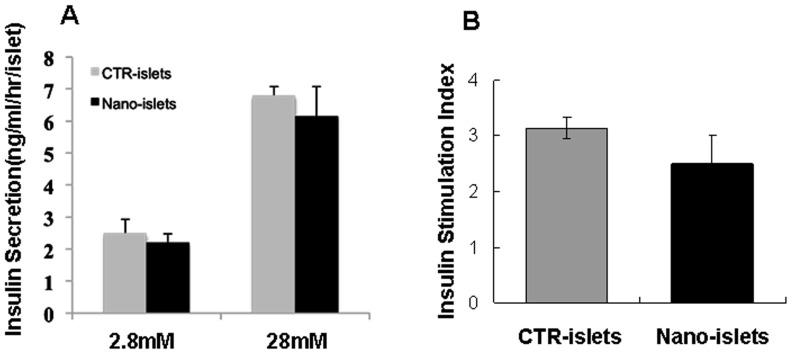
Encapsulation does not affect islet function.(A) Insulin secretion (ng/mL/h/islet) was measured in naked (light grey bars, CTR) and nano-PEG-encapsulated (dark grey bars, Nano) islet cultures cultured overnight after encapsulation stimulated with 2.8 mM, or 28 mM glucose for 24 h. (B) Insulin stimulation index of the naked and nanoparticle-coated islets shown in (A). At least 20 islets were included in each group, and the data represents 3 individual experiments.